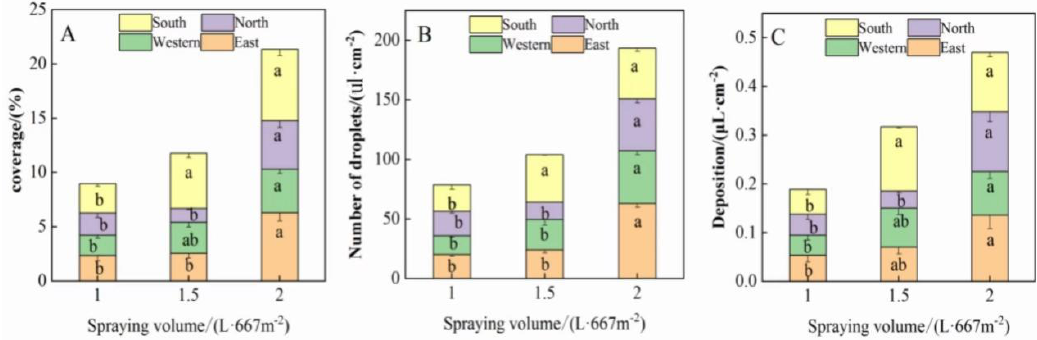
Figure 5. Comparison of different spray amounts on fog droplet effects in four directions of the ‘Kuerle Xiangli’ canopy: ( A ). comparison of different spray amounts on the droplet coverage in four directions of the ‘Kuerle Xiangli’ canopy, ( B ). comparison of different spray amounts on the droplet density in four directions of the ‘Kuerle Xiangli’ canopy, ( C ). comparison of different spray amounts on the amount of droplet deposition in four directions of the ‘Kuerle Xiangli’ canopy. Different lowercase letters indicate significant difference in the same direction among different treatments ( p < 0.05).